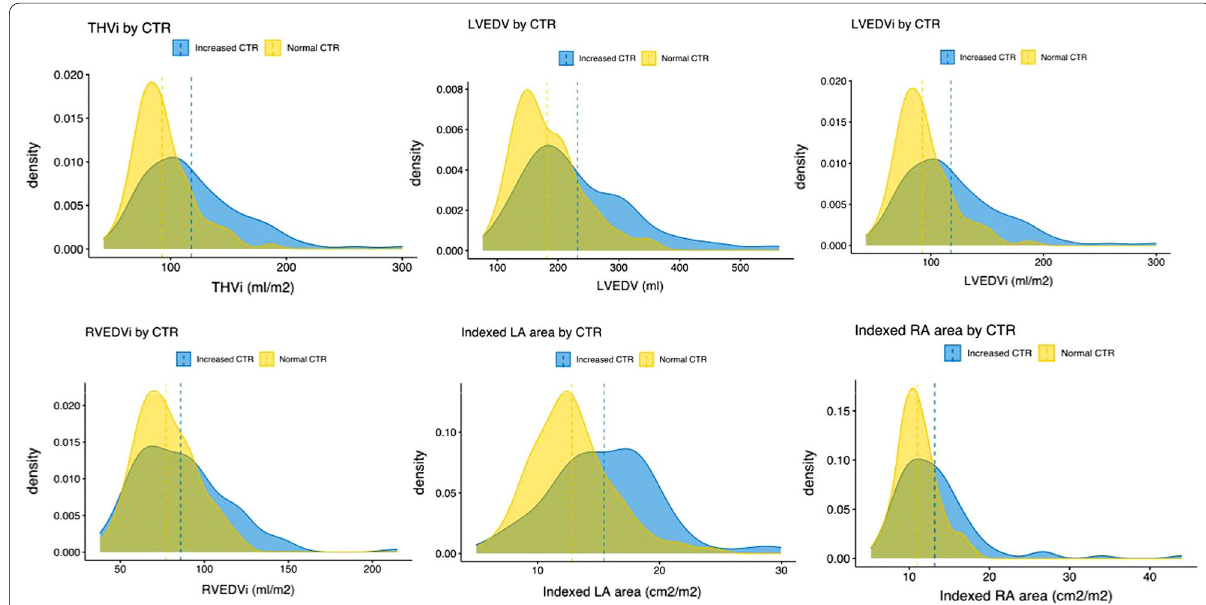
Fig. 4 Density plots representing distributions of cardiac MRI parameters in patients with normal and increased CTR. Density plots are a variation of histograms that allow to observe the distribution of a variable in a dataset in a continuous fashion. They are instrumental in demonstrating the extensive overlap of cardiac MRI derived values between patients with normal and increased CTR. Dashed lines represent the means for each distribution. Note that mean values are larger in patients with CTR > 50%. This explains the described positive but weak correlations. THVi total heart indexed volume, LVEDV left ventricular end-diastolic volume, LVEDVi left ventricular indexed end-diastolic volume, RVEDVi right ventricular indexed end-diastolic volume, LA left atrium, RA right atrium, CTR cardiothoracic